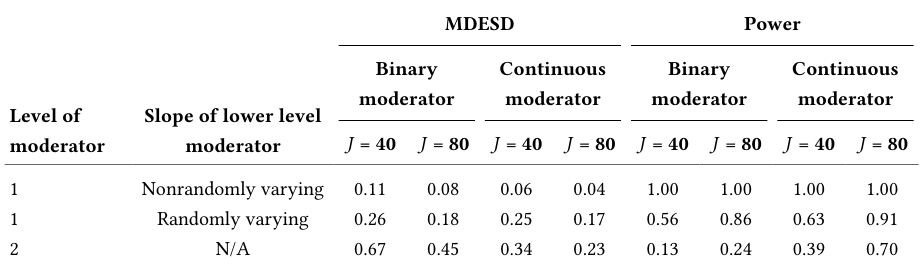
MDESD and Statistical Power of Two-Level